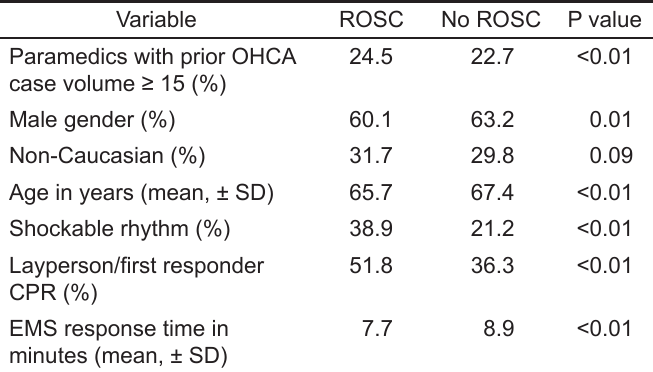
Table 2. Univariate comparison of patients enrolled in a study to determine the effect of paramedic OHCA case volume on ROSC comparing patients with and without ROSC.